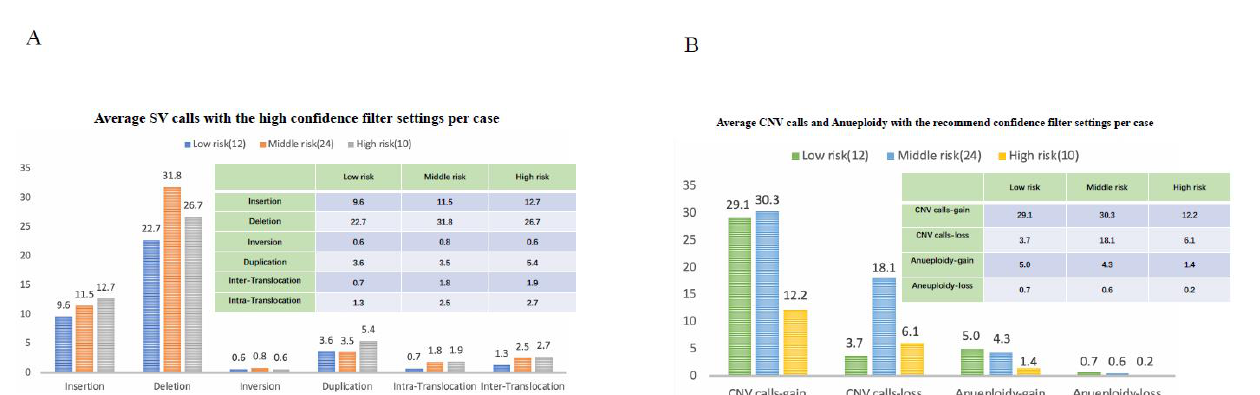
Table 6. Correlations of recurrent putative fusion genes with clinical features of B-ALL in children. Putative Gene Fusion Clinical features Spearman ρ